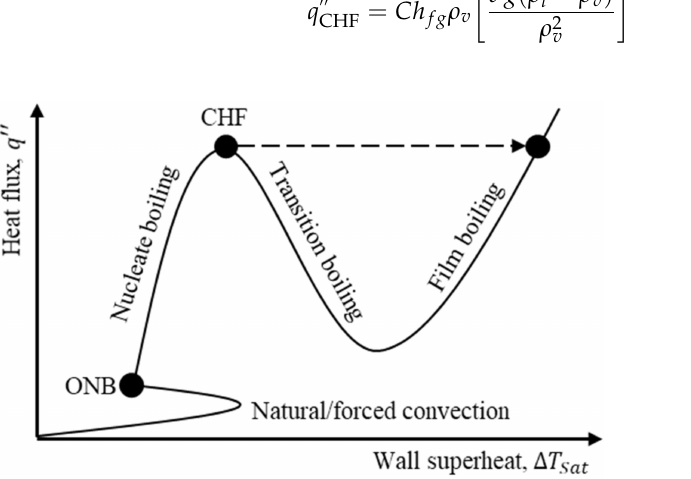
Figure 3. Boiling curve showing typical relationship between wall superheat (difference in tempera- ture between the heated surface and liquid) and heat